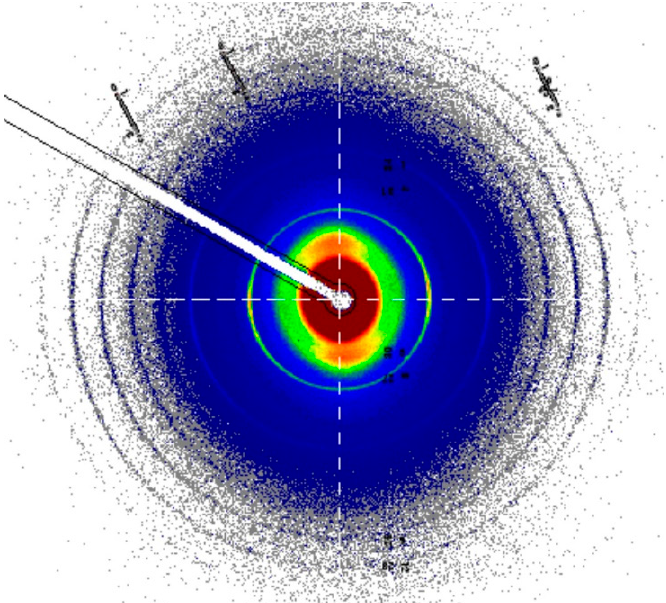
Figure 5. Representative SAXS pattern of the equine amniotic